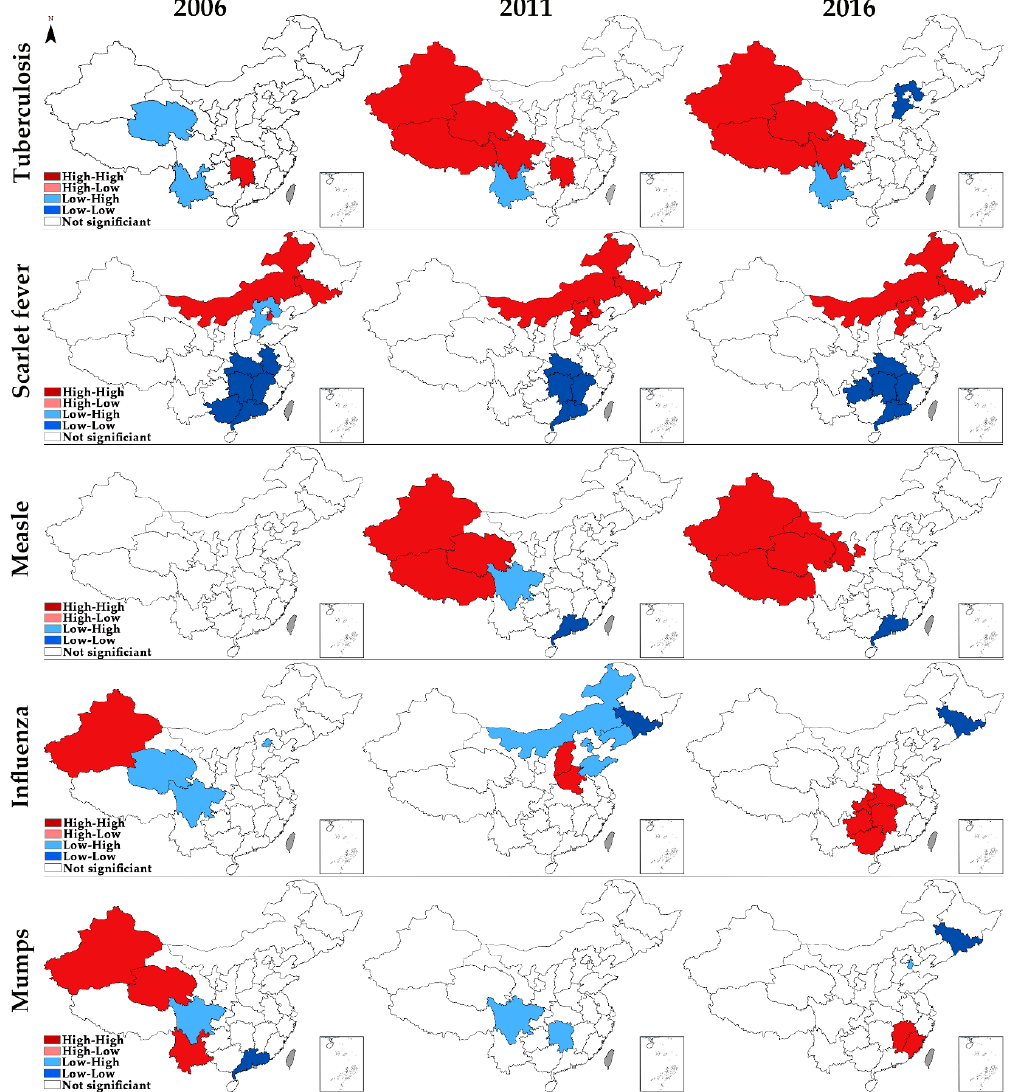
Figure 4. Spatial clusters of RIDs in 2006, 2011, and 2016.